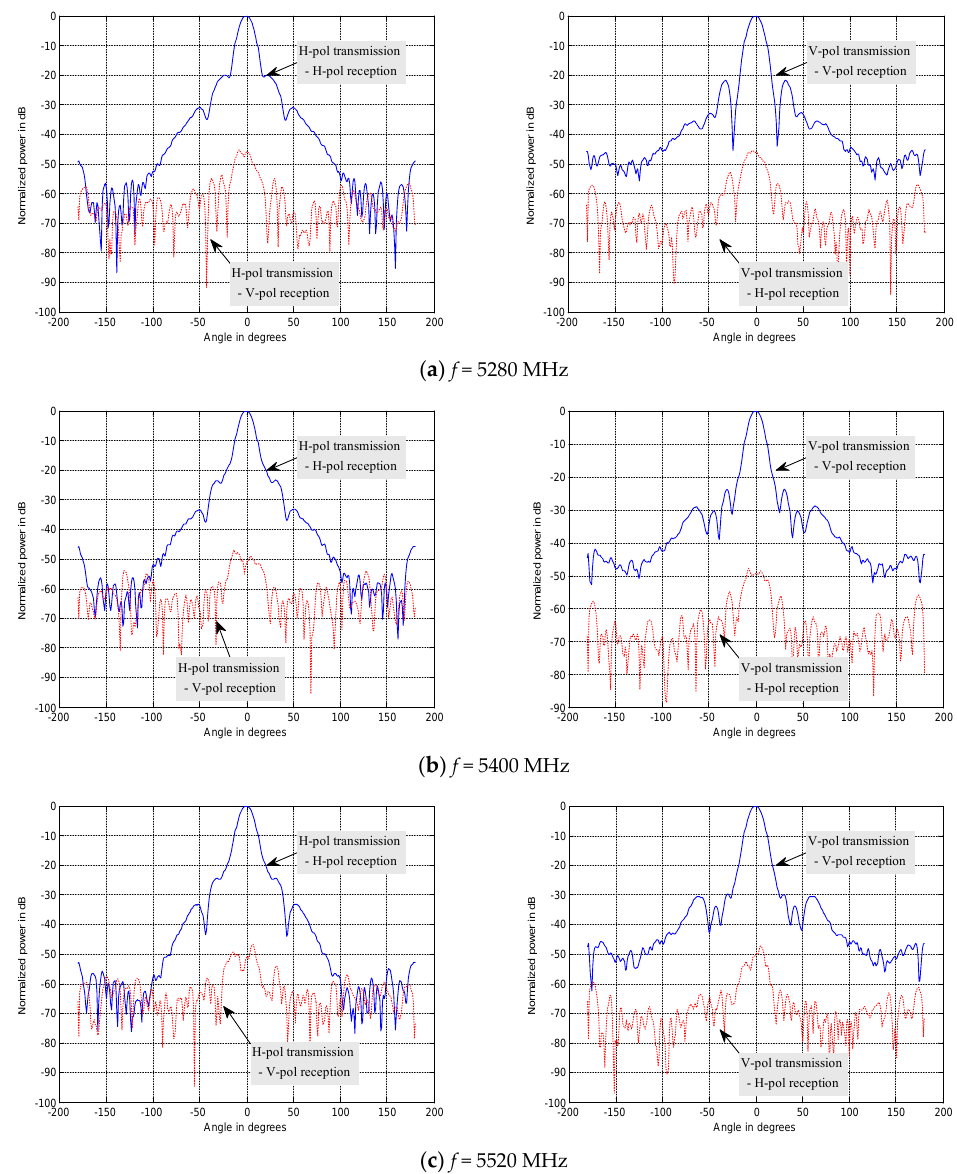
Figure 5. Patterns measured in the anechoic chamber (including polarization isolation).